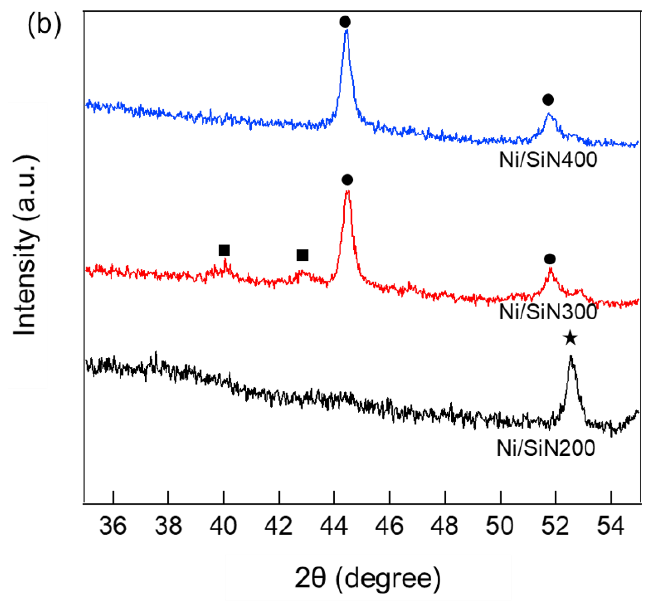
Figure 3. Powder X-ray diffraction patterns of Ni/SiNX samples pyrolyzed at 200, 300, 400 °C: 2θ = ( a ) 10 – 90° and ( b ) 35 – 55°.